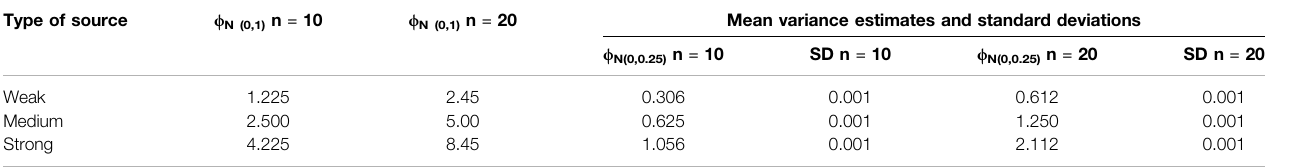
TABLE 2| MeanVarianceEstimates and StandardDeviationsofLatentVariableObservedinInvestigating Interval-levelDatawith Variances of0.25 forDatasets with10and 20 Columns (400 Datasets). Type of source ϕ N (0,1) n = 10 Mean variance estimates and standard